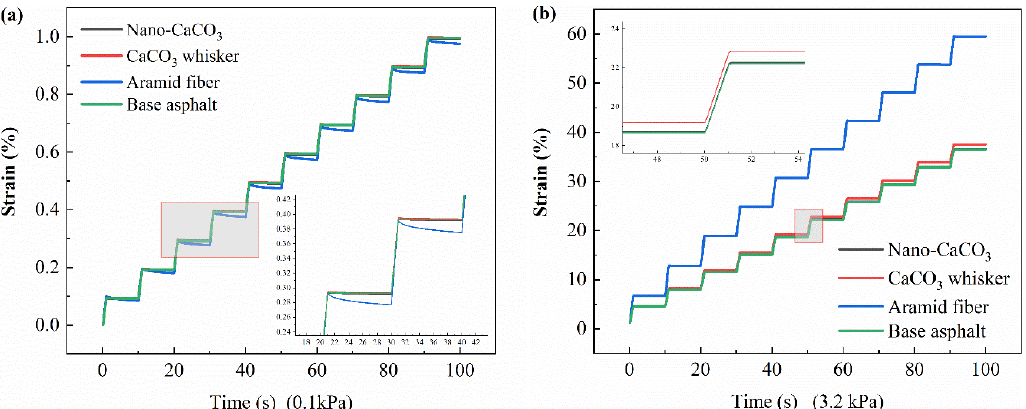
Figure 5. Multiple Stress Creep Recovery (MSCR) curves of modified asphalt binders and base asphalt binder at ( a ) 0.1 kPa, ( b ) 3.2 kPa. binder at ( a ) 0.1 kPa, ( b ) 3.2 kPa. Table 5. The calculation results of recovery rate (R) and average unrecoverable creep compliance (J nr ).